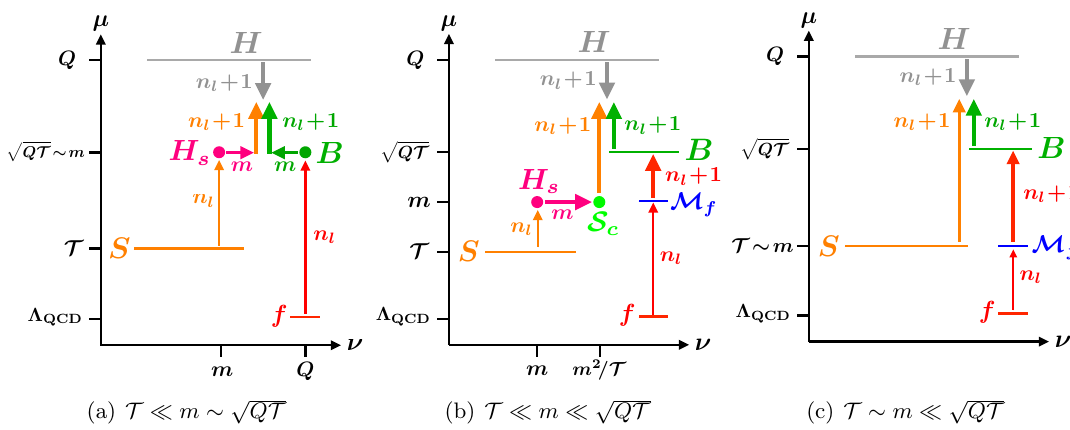
Figure 6 . Illustration of the renormalization group evolution for beam thrust of the hard, beam, soft, and parton distribution function in invariant mass and rapidity. The anomalous dimensions for each evolution step involve the displayed number of active quark (cid:13)avors. The label m indicates that the corresponding evolution is mass